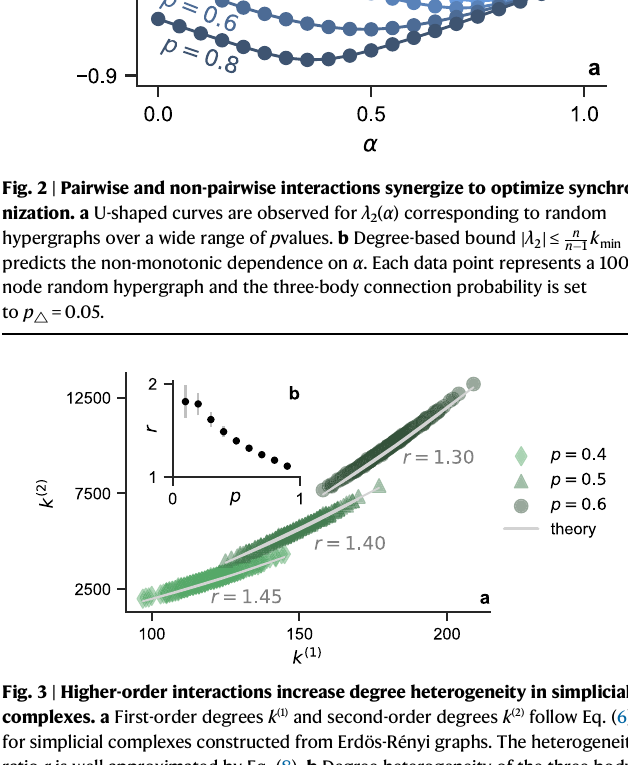
Fig. 3 | Higher-order interactions increase degree heterogeneity in simplicial complexes. a First-order degrees k (1) and second-order degrees k (2) follow Eq. (6) for simplicial complexes constructed from Erdös-Rényi graphs. The heterogeneity ratio r is well approximated by Eq. (8). b Degree heterogeneity of the